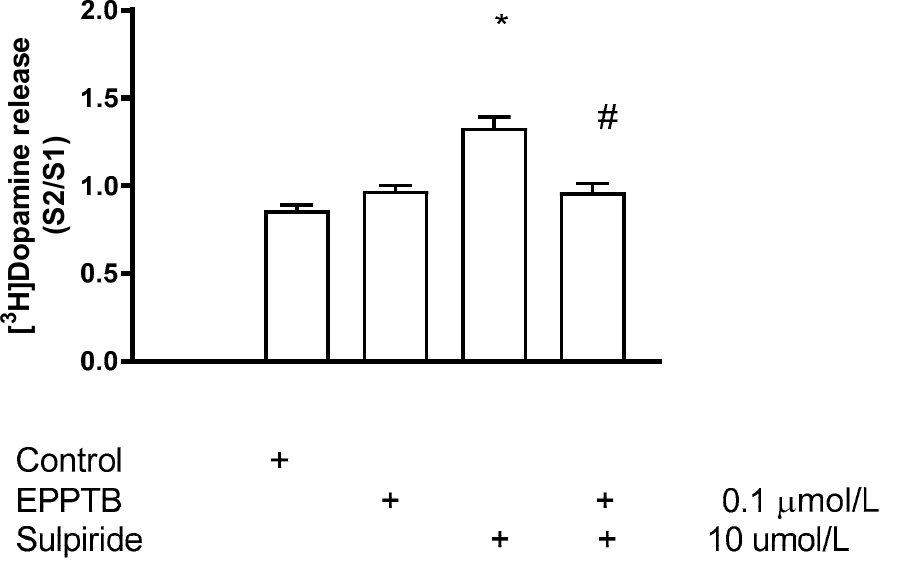
Figure 22. EPPTB reversed the sulpiride-induced increase of [ 3 H]dopamine release from rat striatum. For the experimental procedure, see Figure 2A. EPPTB or sulpiride was added to the slices from fraction 8 in a concentration of 0.1 or 10 µ mol/L, respectively. When EPPTB and sulpiride were added in combination, EPPTB (0.1 µ mol/L) was added from fraction 1 and sulpiride (10 µ mol/L) was added from fraction 8 and drugs were maintained throughout the experiment. Sulpiride did not alter resting [ 3 H]dopamine release on its own. One-way ANOVA followed by the Dunnett’s test, F(3,21) = 21.65, p = 0.001, control vs. sulpiride treated groups * p < 0.05. Student t -statistics for two means, sulpiride vs. sulpiride and EPPTB effect # p < 0.05, mean ± S.E.M., n = 4-7.